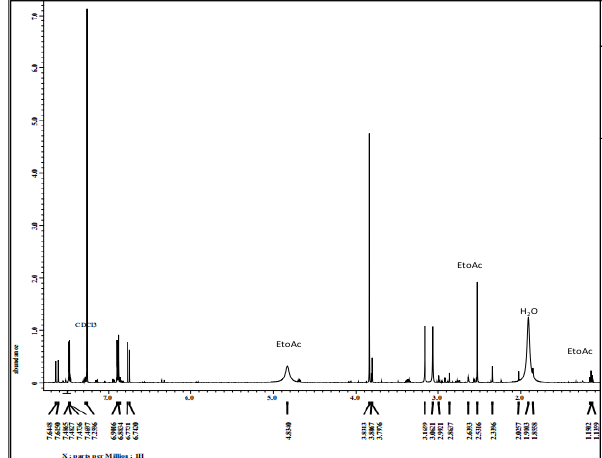
Figure 5. MS data of N,N -dimethyl- p -methoxycinnamamide ( 5 )